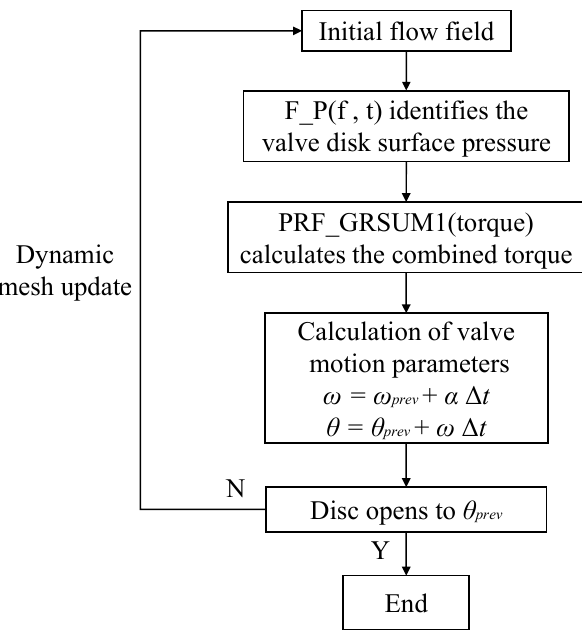
Figure 5. Swing check valve opening process UDF program core steps.